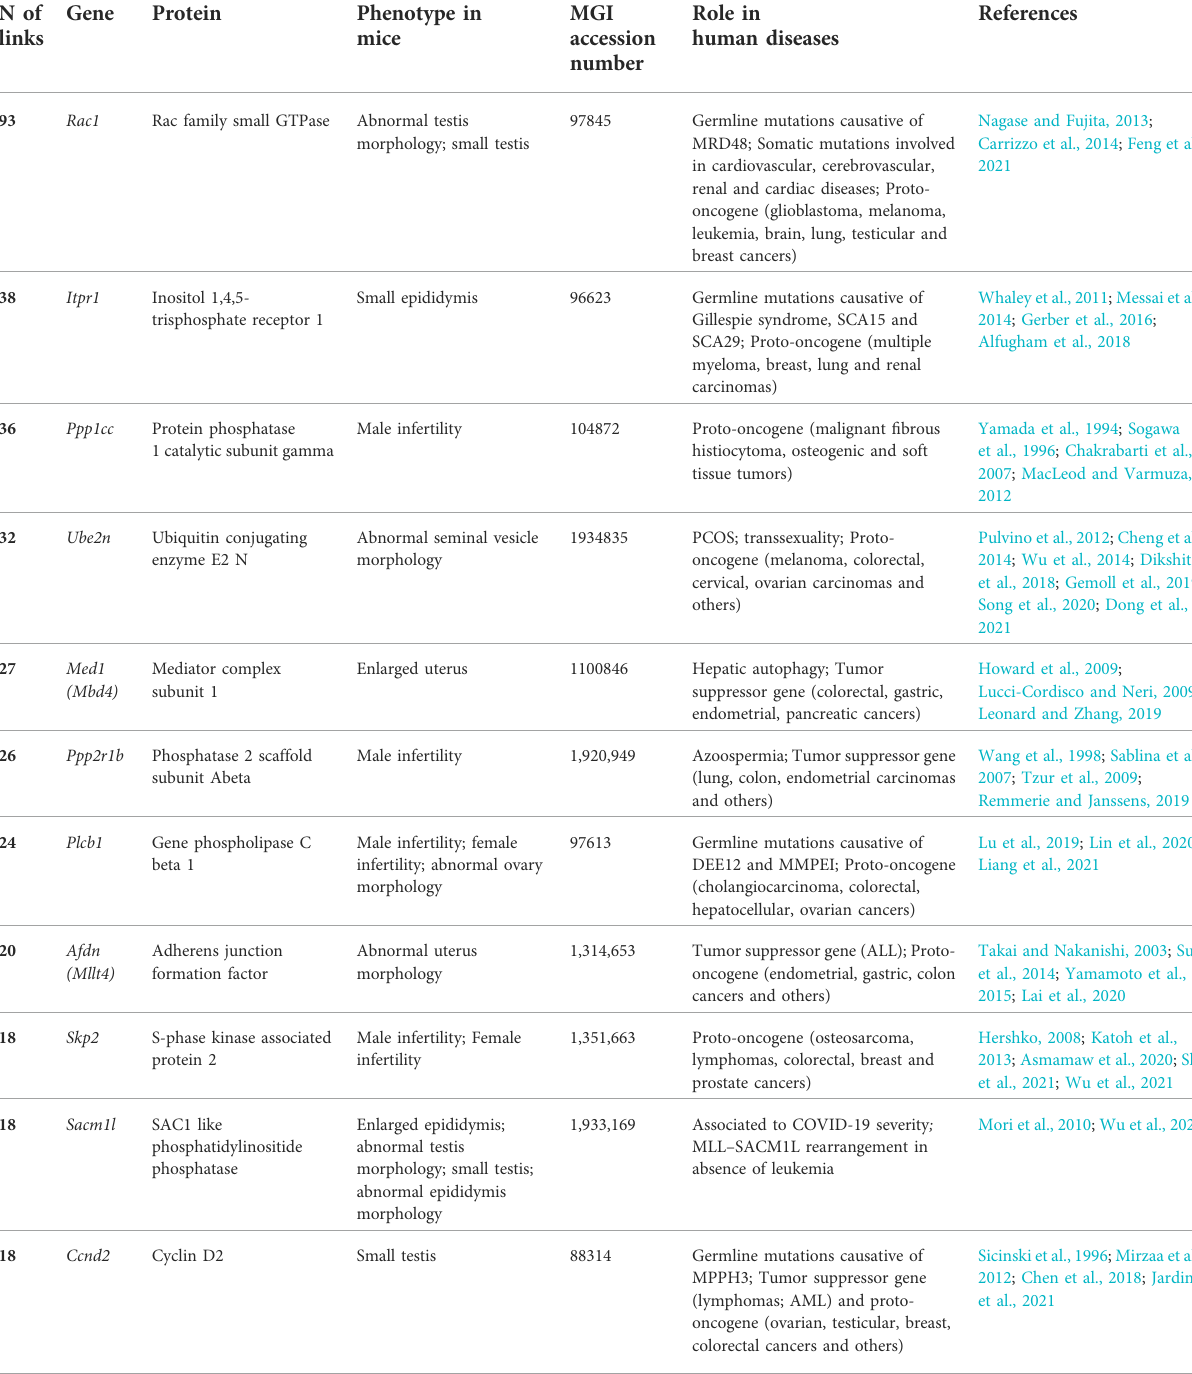
TABLE 4 Genes studied in mice KO models in terms of their relationship with the reproductive system. The table shows the number of links for each gene, the genes and the protein for which codi fi es, the phenotype in mice with the corresponding MGI (mouse genome informatic database accession number), the role in human diseases and their corresponding references. PCOS: Polycystic ovary syndrome; ALL: Acute lymphocytic leukemia; MLL: mixed lineage leukemia; AML: acute myeloid leukemia; MPPH: Megalencephaly-polymicrogyria-polydactyly- hydrocephalus